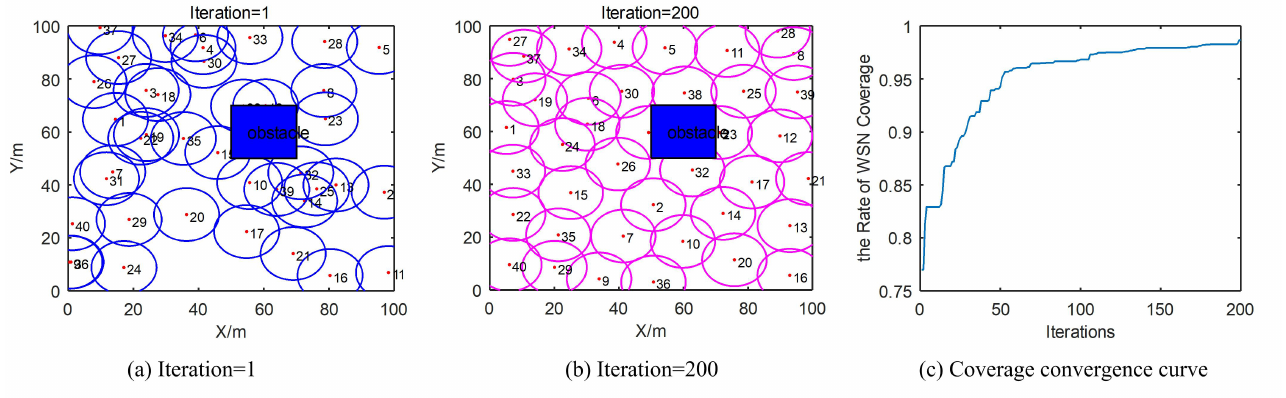
Figure 13. Coverage of obstacle avoidance nodes based on